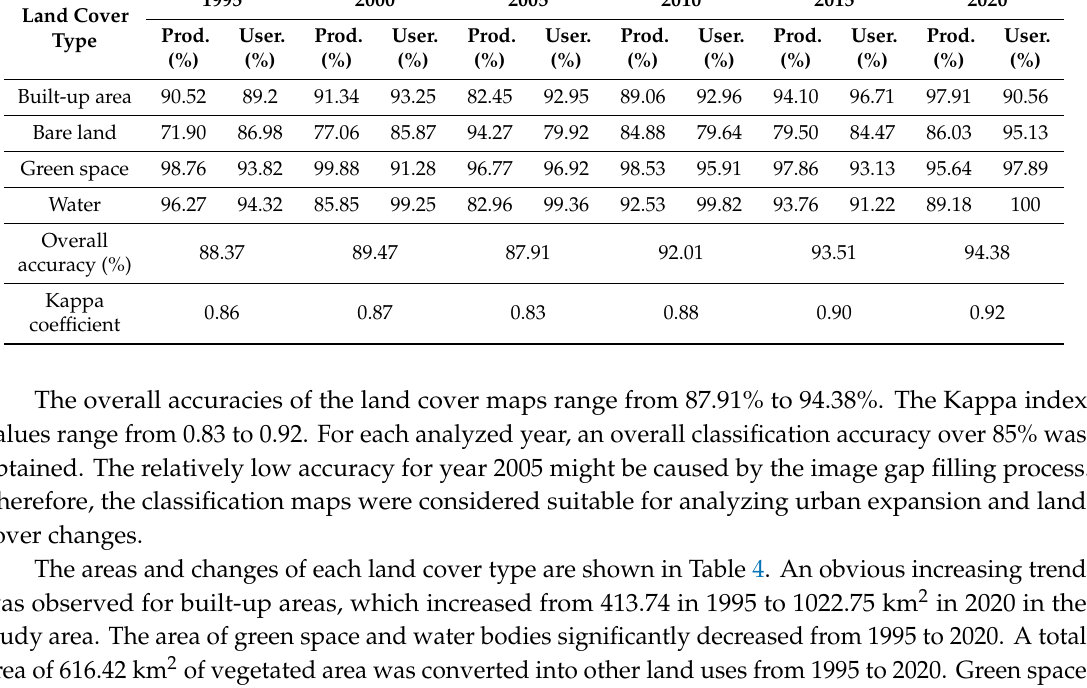
Table 3. Accuracy of classified land cover maps.